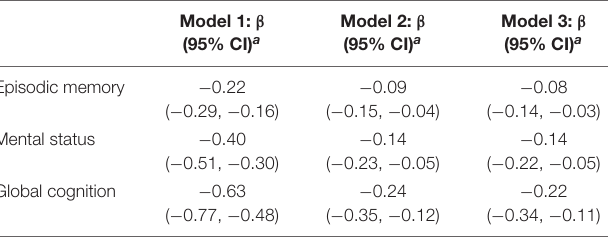
TABLE 1 | Baseline characteristics of study participants in the CHARLS. Characteristics Arthritis